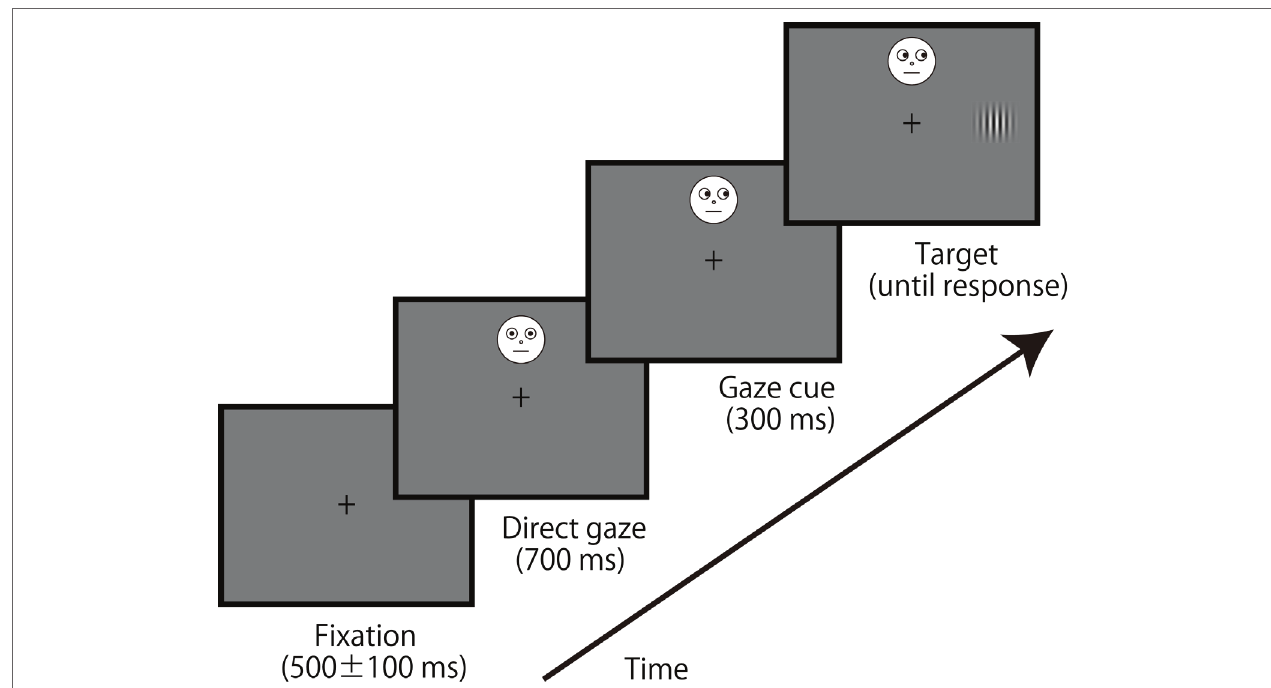
FIGURE 1 | An example of the sequence of events in a typical trial. The face stimulus was presented up to ±7.5 ° of the visual angle (above and below) of vertical eccentricities, but the target was presented horizontally centered in the